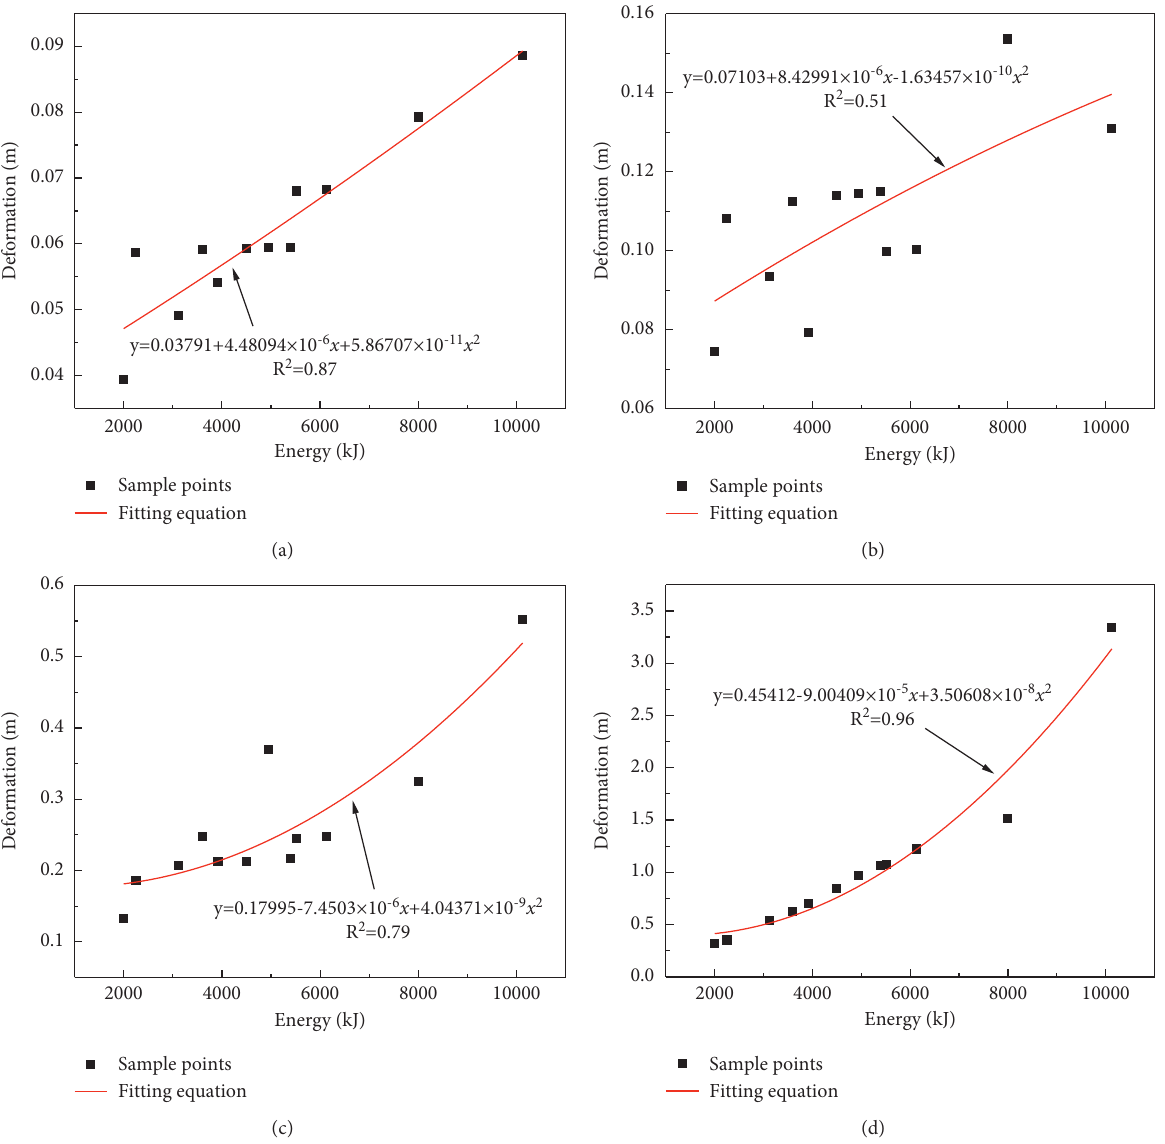
Figure 7: Fitting curve of bow deformation. (a) Fitting curve of sample point 1. (b) Fitting curve of sample point 2. (c) Fitting curve of sample point 3. (d) Fitting curve of sample point 4.